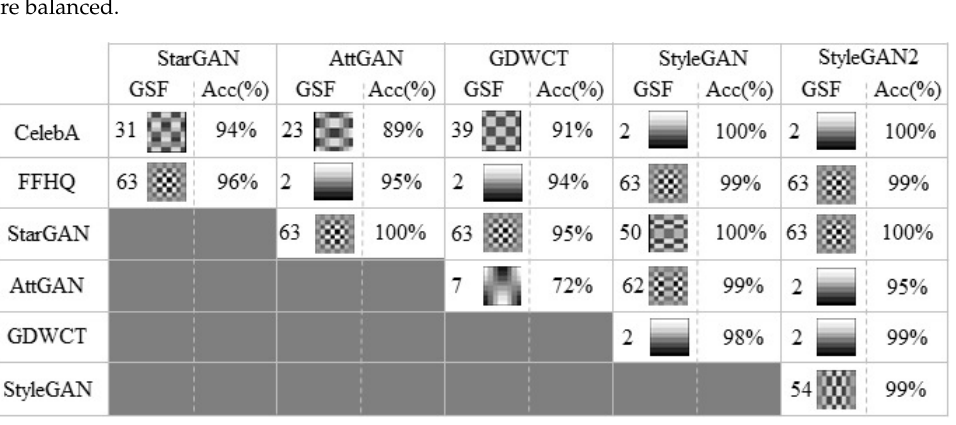
Figure 7. GSF and classification accuracy results (%) obtained for each binary classification